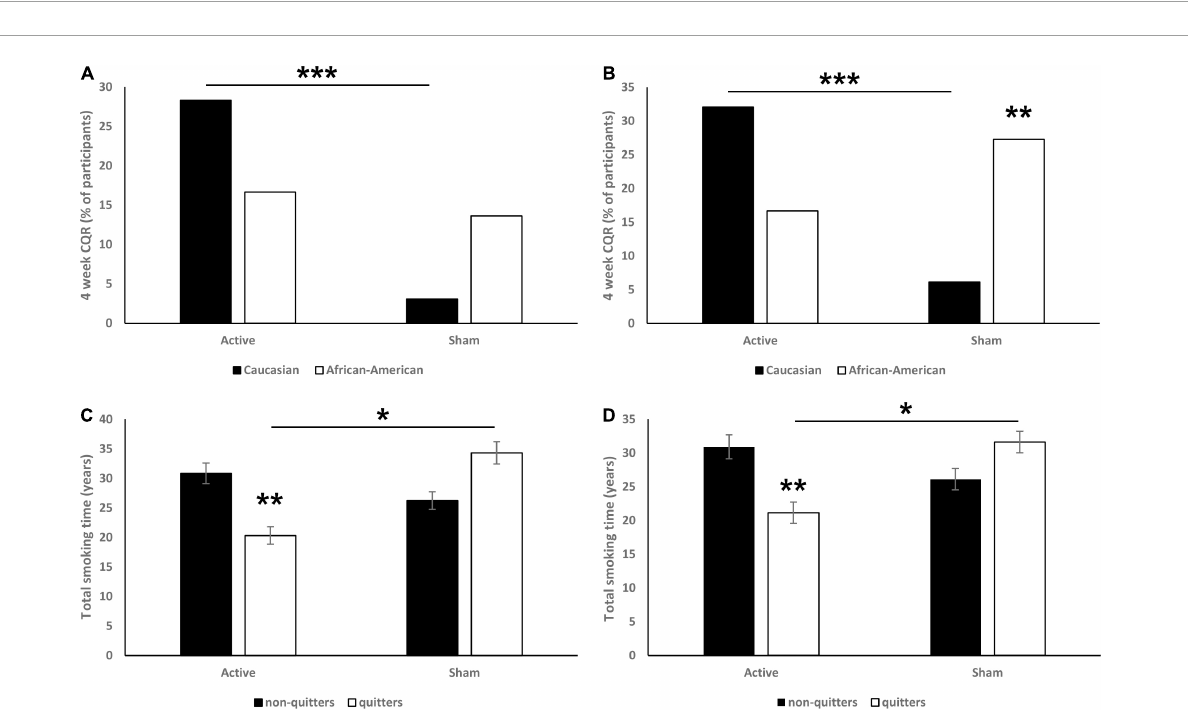
FIGURE3 Effects of race ( A: 6 weeks CQR data, B: 18 weeks CQR data) and total years of smoking ( C: 6 weeks CQR data, D: 18 weeks CQR data) on CQR. On panels (A,B) data are presented as % of participants. On panels (C,D) data are presented as mean ± SEM. * p < 0.05, ** p < 0.01, *** p <